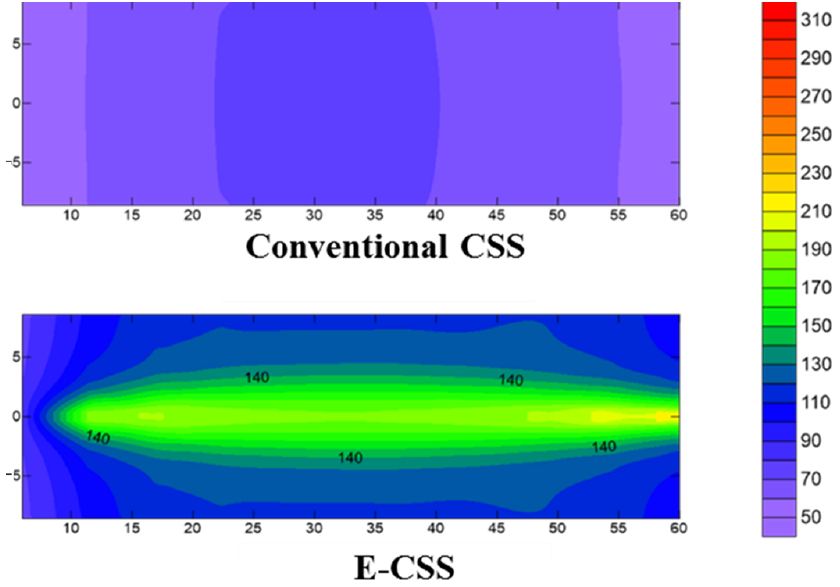
Figure 7. The comparison of the temperature field at the end of the second cycle production phase.